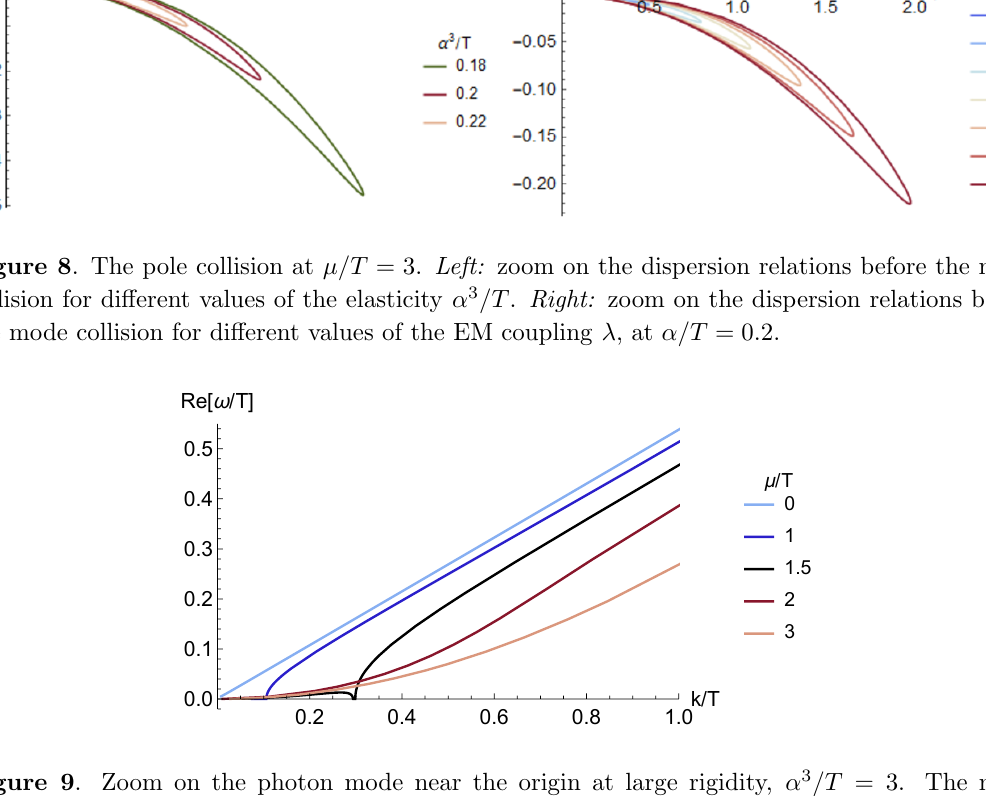
Figure 9 . Zoom on the photon mode near the origin at large rigidity, (cid:11) 3 =T = 3. The mode transition from ordinary sound, to sound with a k -gap, to sound with a quadratic modulation at small k when increasing (cid:22)=T is shown. In particular, an intermediary \exotic" dispersion is obtained for (cid:22)=T = 1 : 5. At large k, they all exhibit the same v sound